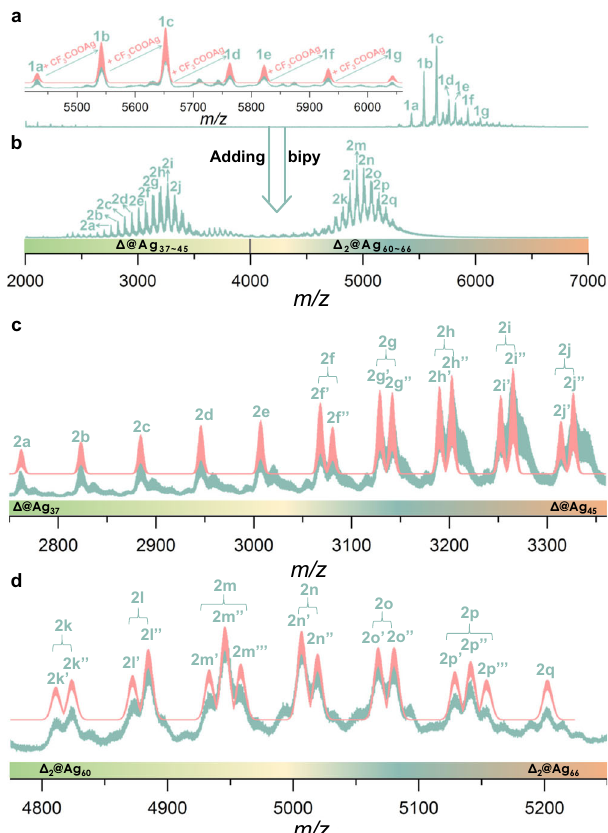
Fig. 4 Electrospray ionization mass spectrometry (ESI-MS) of SD/Ag51b before and after adding bipy. Positive-ion ESI-MS of SD/Ag51b dissolved in CH 3 OH before ( a ) and after adding bipy ( b ); Δ = PW 9 O 34 9 − . The charge states for all labeled species in ( a ) and ( b ) are + 2 and + 3, respectively. Inset: The expanded experimental (green line) and simulated (red line) isotope-distribution patterns of 1a – 1g . The expanded experimental (green line) and simulated (red line) isotope-distribution patterns of 2a – 2j ( c ) and 2k – 2q ( d